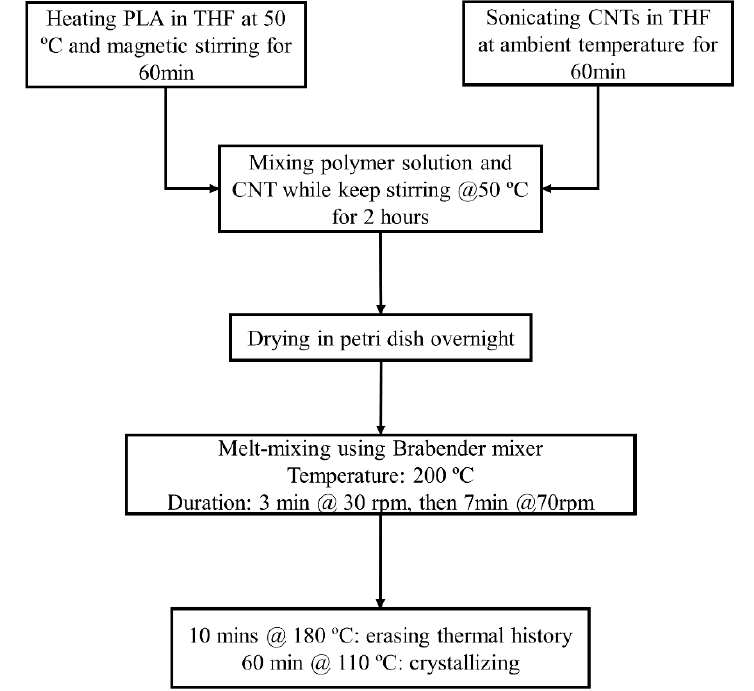
Figure 1. Fabrication process of the CNT-PLA thin films.